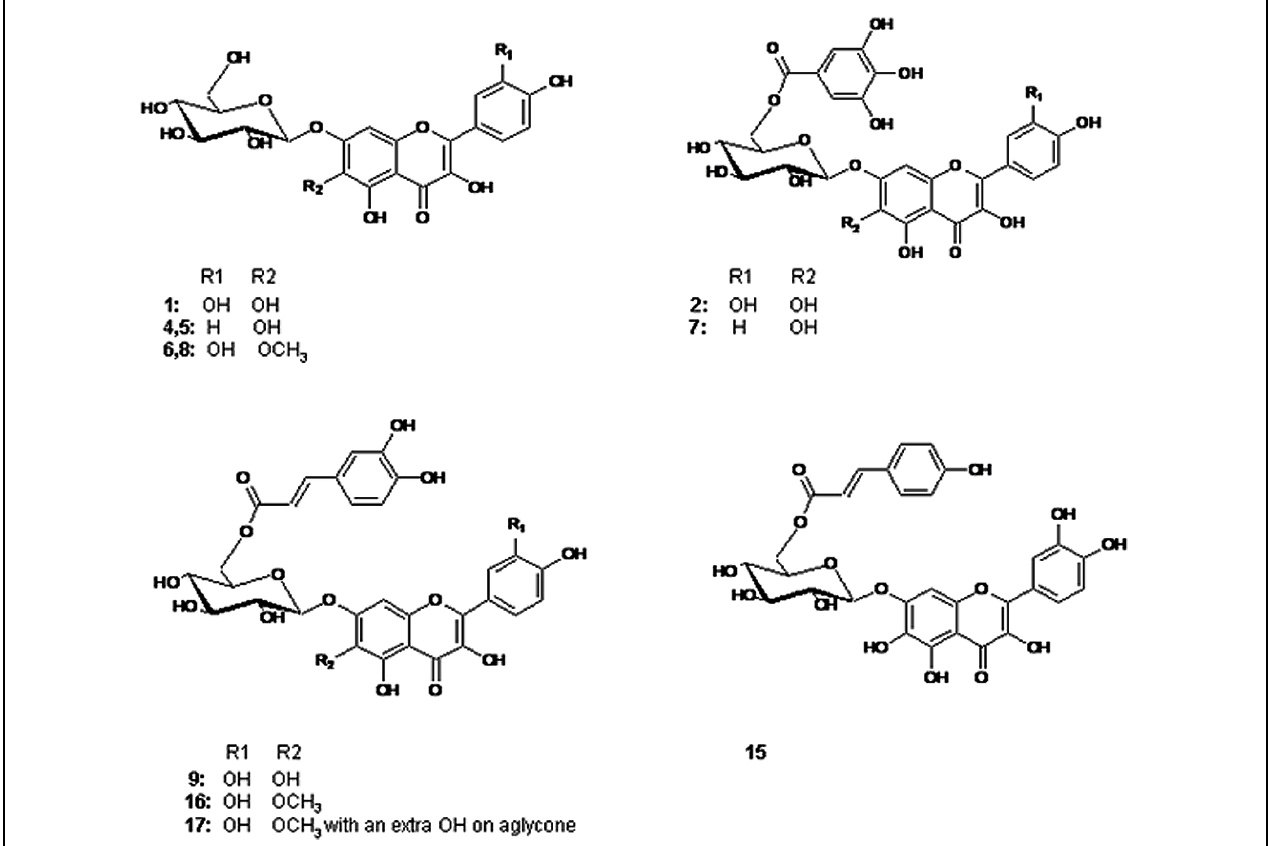
FIGURE 1 | Structures of the flavonols identified in the examined Tagetes minuta . 1 : 6OH Qc 7-glc, 4, 5 : 6OH Kf 7-glc, 6, 8 : 6MeO Qc 7-glc, 2 : 6OH Qc 7Gao Glc, 7 : 6OH Kf 7Gao Glc, 9 : 6OH Qc 7Caf Glc, 15 : 6OH Qc 7Cum Glc, 16 : 6MeO Qc 7Caf Glc, 17 : 6MeO Qc 7Caf Glc with a OH on aglycone. Qc = quercetin; Kf = kaempferol; Glc = glucoside; Gao = galloyl; Caf = caffeoyl; Cum =